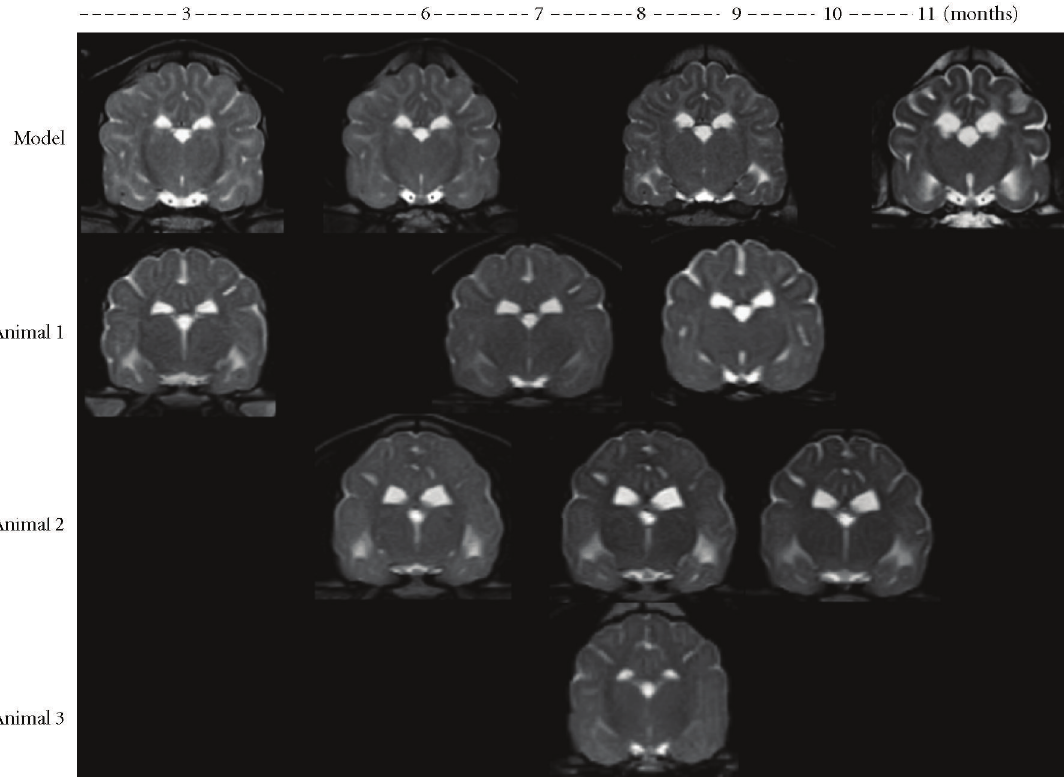
Figure 2: Serial changes in a ff ected dogs (transverse T2W images at the thalamus/3rd ventricle level). Subcortical T2W hyperintensity was consistently observed at any timepoint. T2W hypointensity in the internal capsule was also recognized in the a ff ected laboratory animal (model). Atrophic changes, which were indicated by ventricular enlargement and well-demarcated sulci, were observed in all a ff ected dogs (model and animals 1–3) from 8 to 9 months of